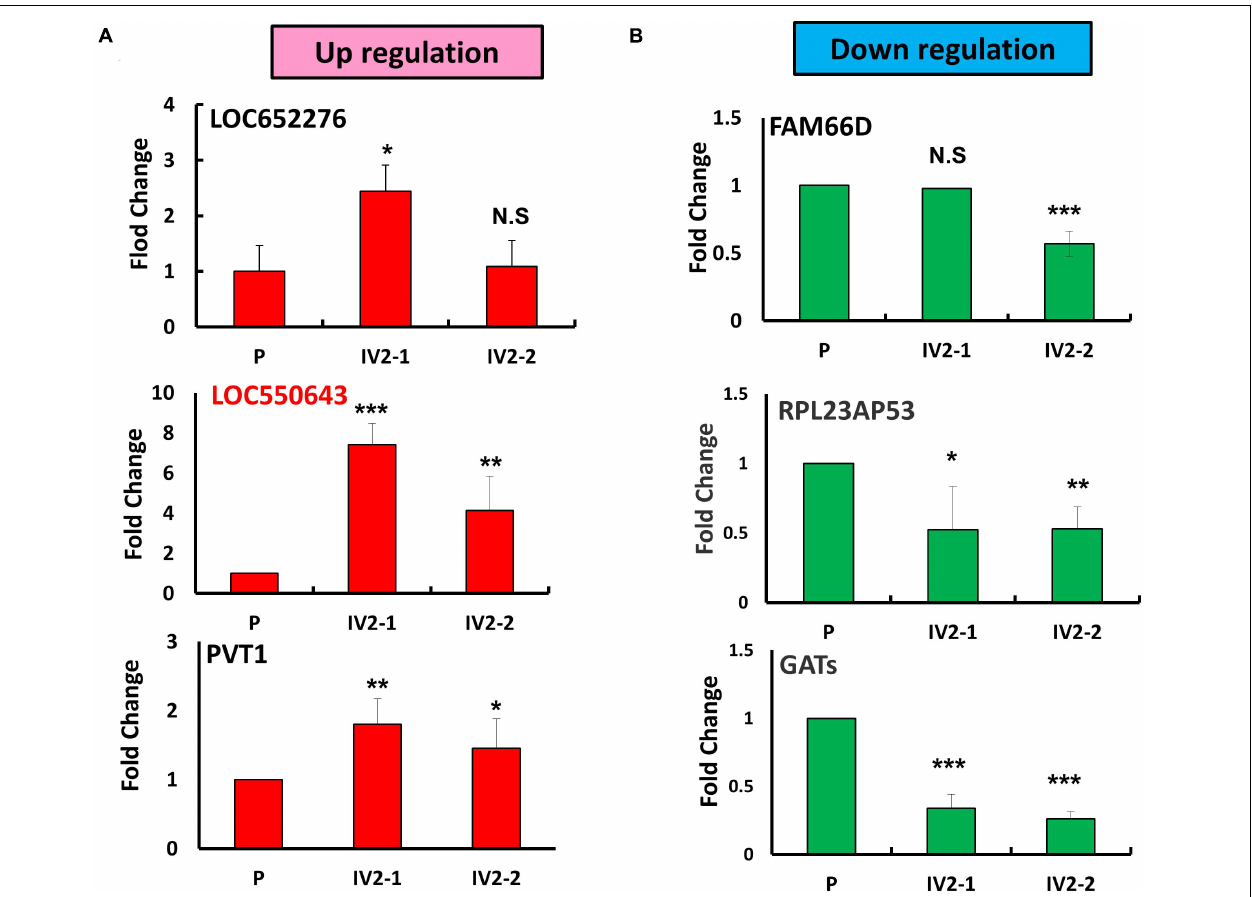
FIGURE 2 | Identification of metastasis-related lncRNA candidates in MDA-MB-231-IV2 cells. (A) Expression levels of the three putative oncogenic lncRNA candidates examined in the parental MDA-MB-231, MDA-MB-231-IV2-1, and MDA-MB-231-IV2-2 cells. (B) Expression levels of the three tumor-suppressive lncRNA candidates examined in the parental MDA-MB-231-P, MDA-MB-231-IV2-1, and MDA-MB-231-IV2-2 cells. All experiments were carried out in triplicate. Using Student’s t -test to analyze our data and p < 0.05 was considered significant (* p < 0.05, ** p < 0.01, and *** p <